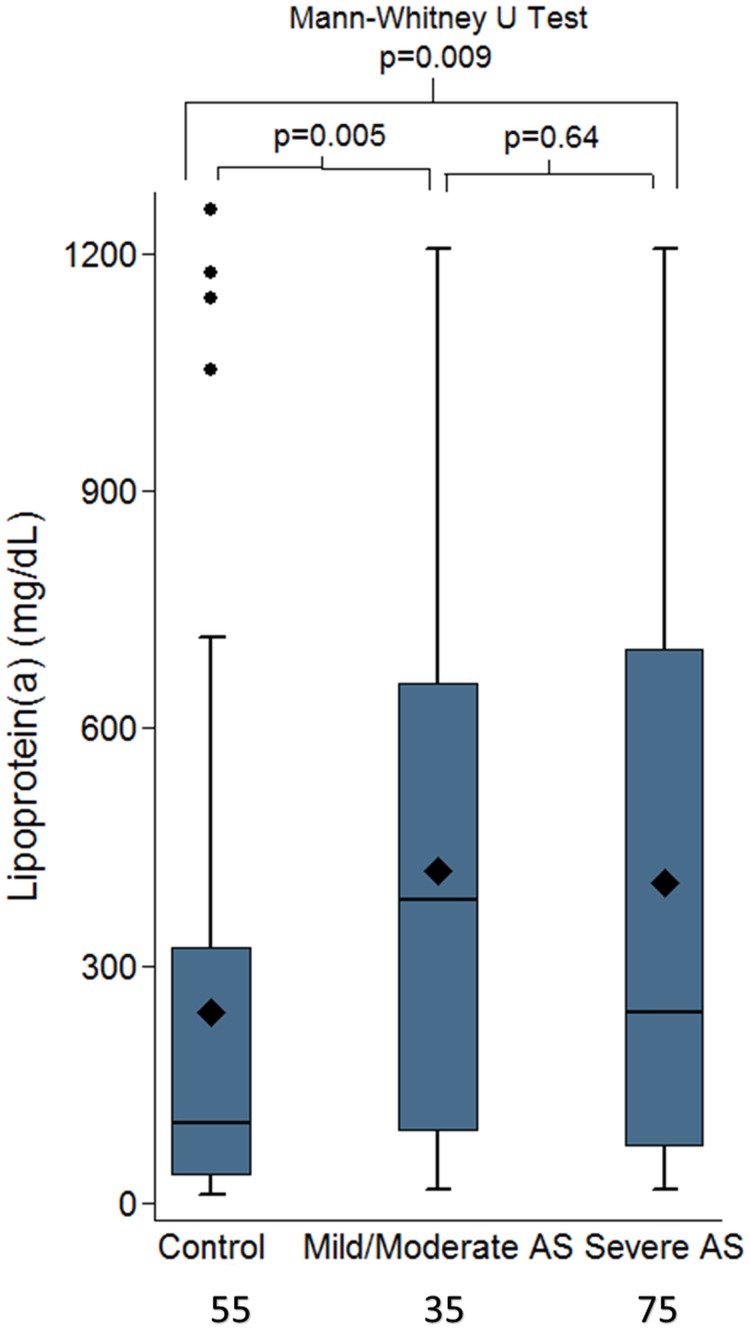
Box plots comparing the controls vs the mild/moderate aortic and severe aortic stenosis patients confirming a significant difference between the controls and either of the groups.